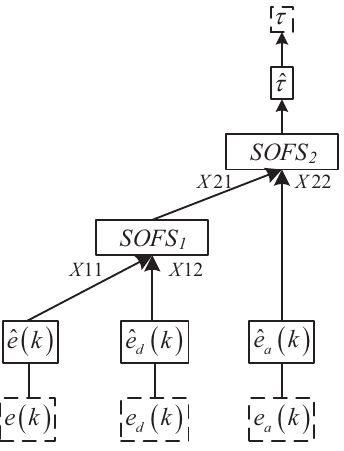
Figure 8. The structure of the DHSOIT2FS in